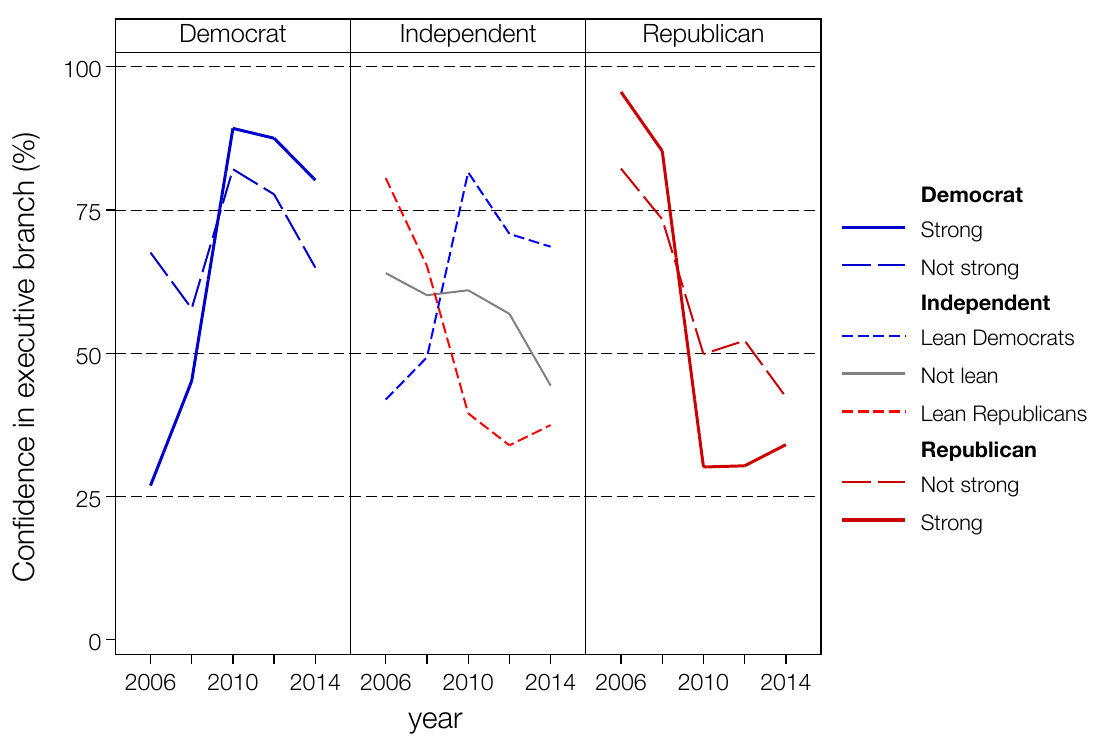
Figure 7: Confidence in people running the federal government by year, political party preference, and strength or leaning of party